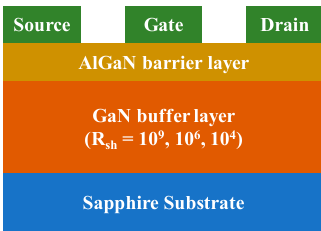
Figure 1. Schematic illustration of the AlGaN / GaN HEMTs with di ff erent GaN bu ff er resistance (no surface